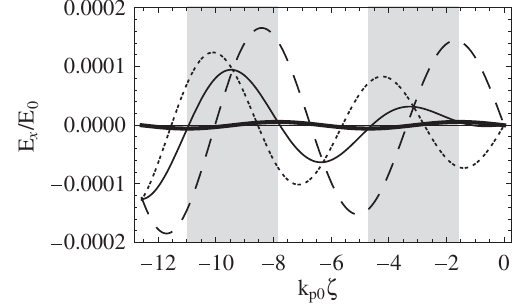
FIG. 5. Transverse electric field at x=r 0 ¼ 0 : 1 driven by the Gaussian and Hermite-Gaussian pulses calculated in a matched plasma channel for a 1 =a 0 ¼ 0 : 5 (dashed line), a 1 =a 0 ¼ 1 = (solid line), and a 1 =a 0 ¼ 0 : 8 (dotted line). For comparison the transverse electric field calculated without the contribution of the plasma channel is shown for a 1 =a 0 ¼ 1 = i.e., for a flattop intensity profile near axis as shown in Fig. 4. The gray areas indicate the accelerating region for electrons < 0 ( E z